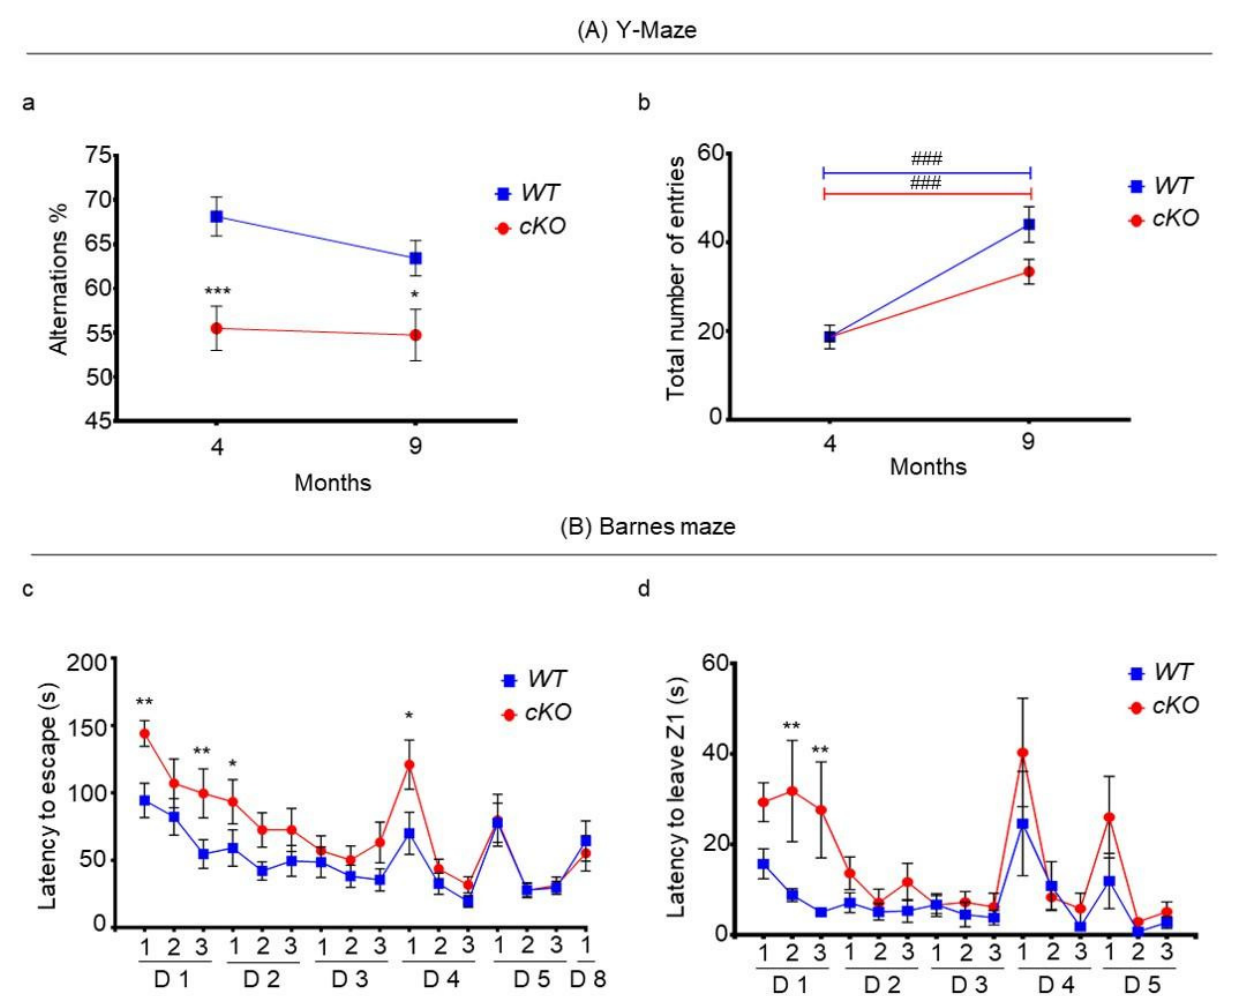
Figure 6. Short- and long-term memory assessment. ( A ) Y-maze for WT ( n = 20) and cKO ( n = 18) mice. ( a ) Alternation (%) at the ages of 4 and 9 months. ( b ) Total number of entries at the ages of 4 and 9 months. ( B ) Barnes maze for WT ( n = 15) and cKO ( n = 15) mice. ( c ) The time taken to find the escape chamber, measured 3 times per day for 5 consecutive days. On day 8, one single test session was performed to assess long-term memory. ( d ) Time taken to leave departure zone (Z1), measured 3 times per day for 5 consecutive days. Statistical significance between cKO and WT mice at different time points is represented as: * P ≤ 0.05, ** P ≤ 0.01, *** P ≤ 0.001. Statistical significance with time in cKO or WT mice is represented as: # P ≤ 0.05, ## P ≤ 0.01, ### P ≤ 0.001.